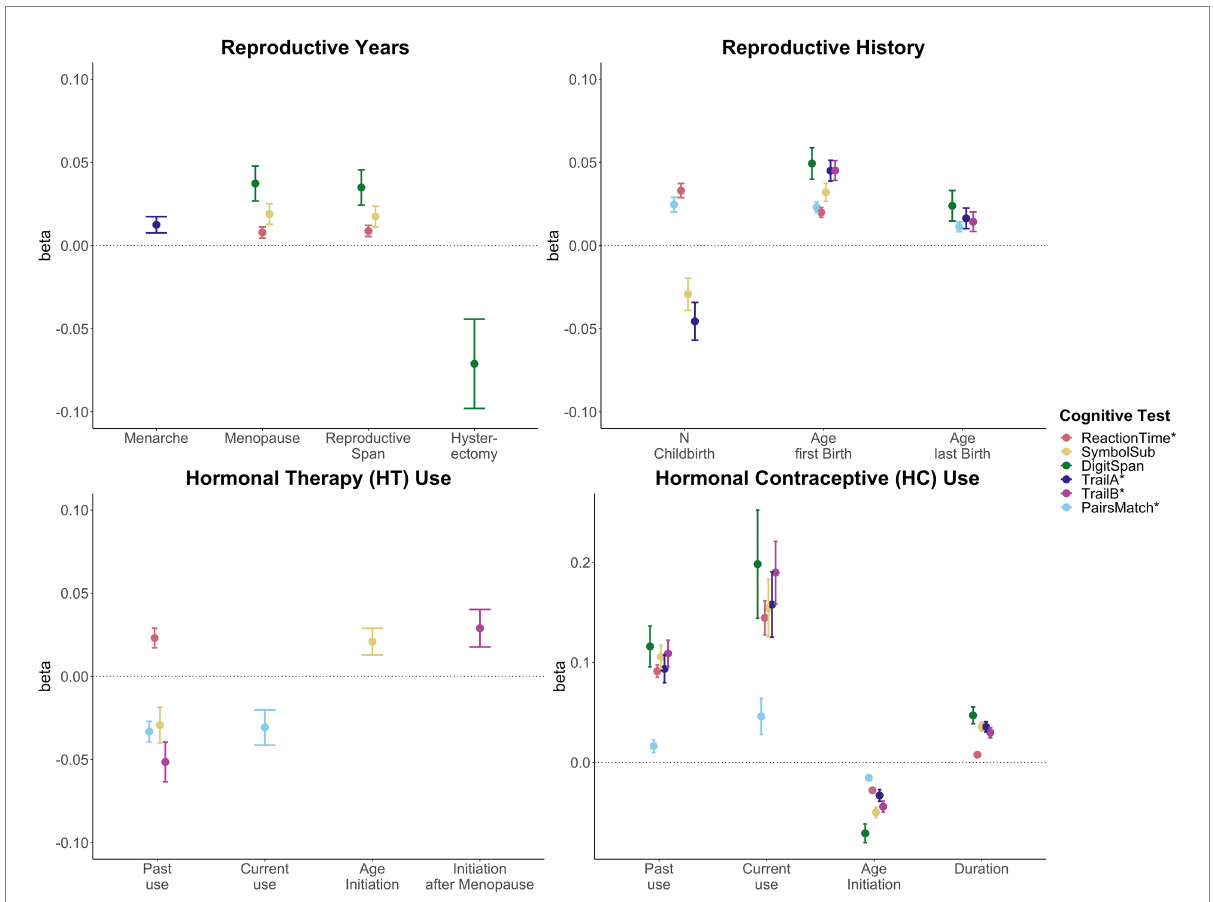
FIGURE 2 Significant associations between female-specific factors and cognitive performance. Point plot of beta-values with standard error from separate multiple regression analysis with cognitive task as dependent variable and female-specific variables as independent variable. All models are adjusted for age, education, body mass index, Townsend deprivation score, and lifestyle score. In addition, the analyses for reproductive span and age at menopause were corrected for use of HT, use of HC, history of hysterectomy and bilateral oophorectomy, and number of live births. The HT models were additionally adjusted for history of hysterectomy and bilateral oophorectomy, and the hysterectomy/oophorectomy model was co-varied for use of HT. All variables were standardized prior to performing the multiple linear regression analysis (subtracting the mean and dividing by the standard deviation). For visualization purposes, cognitive tests marked with * are inverted (multiplied by − 1) so that positive beta- values always indicate associations between higher values on the female-specific variables and better performance on cognitive